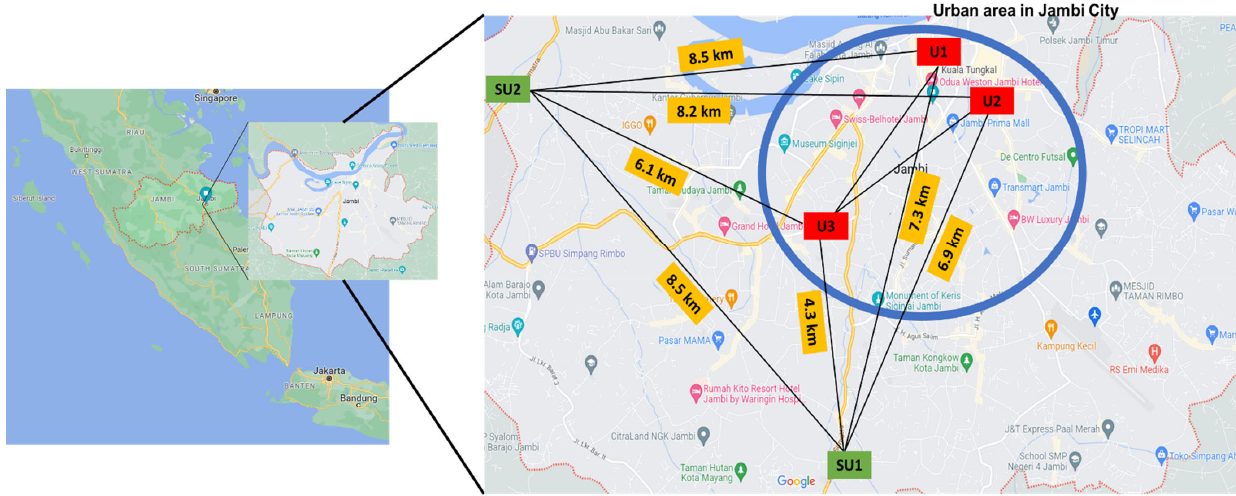
Figure 1. Study sites and selected schools (U1, U2, U3, SU1, and SU2) in Jambi city,